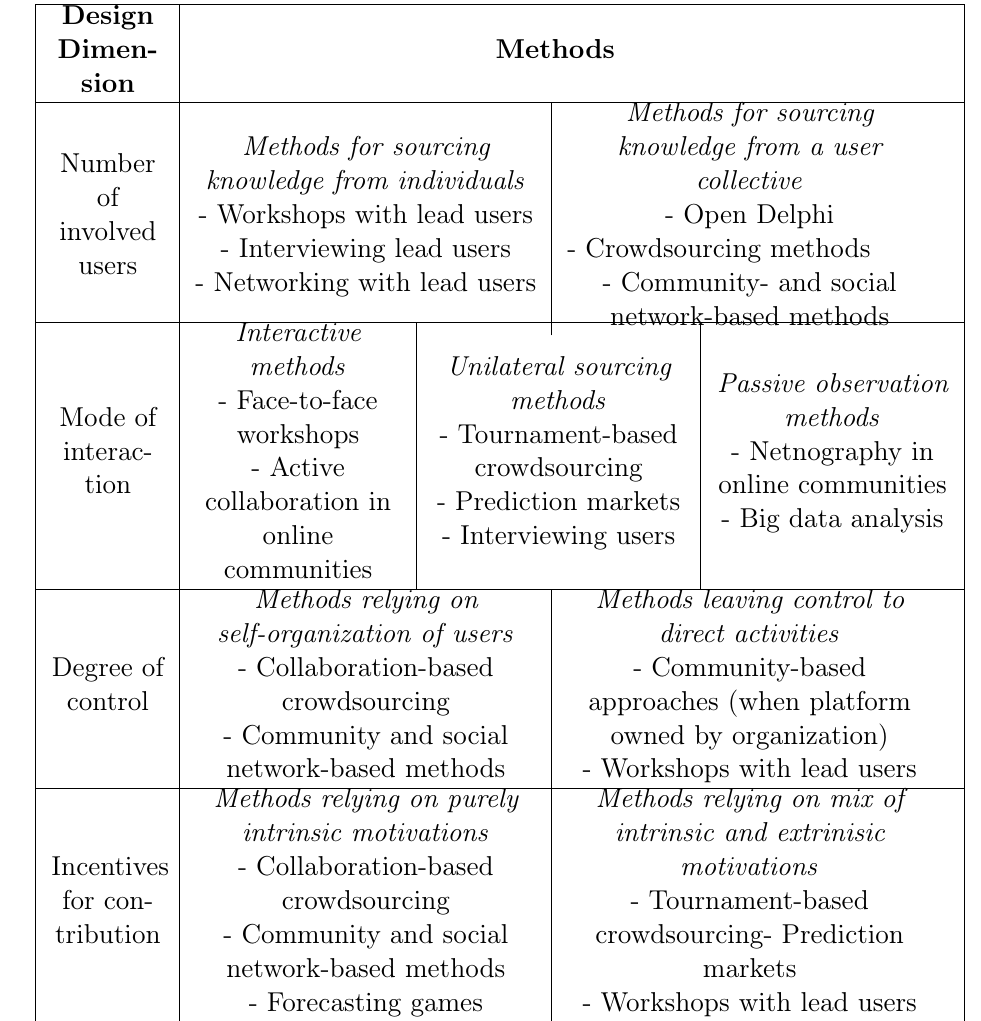
Table 1. Overview of